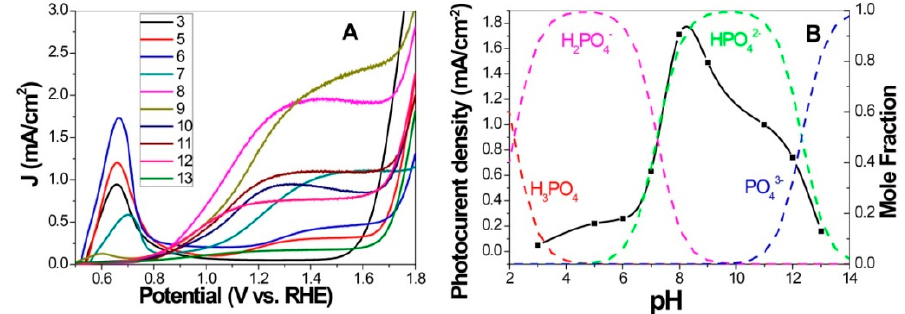
Figure 11. Effect of soaking solution pHs on hematite performance. ( A ) J-V scans collected for P-doped hematite synthesized by phosphate solutions with different pH and annealed at 650 ° C. ( B ) Photocurrent densities obtained at 1.23 V RHE and molar fraction of H x PO 4(3 − x) − species as a function of pH. Adapted with permission from [33]. Copyright 2015 Royal Society of Chemistry.